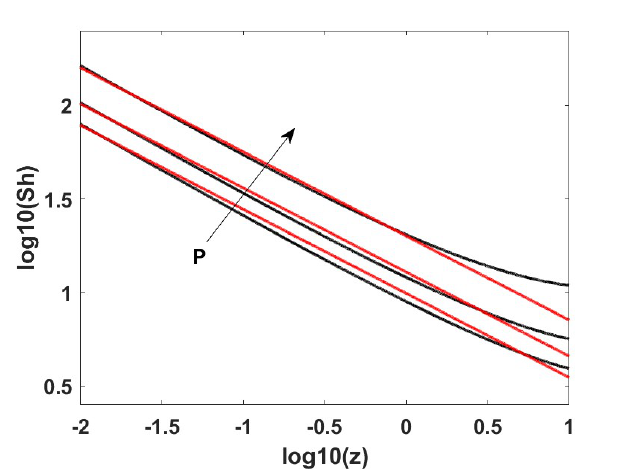
Figure 2. Sherwood number along the length of the reactor evaluated from the simplified 2D model (black curves) and the approximated correlation of Equation (33) (red curves) at Pe = 100, 700 ◦ C, and pressures of 1, 3, and 10